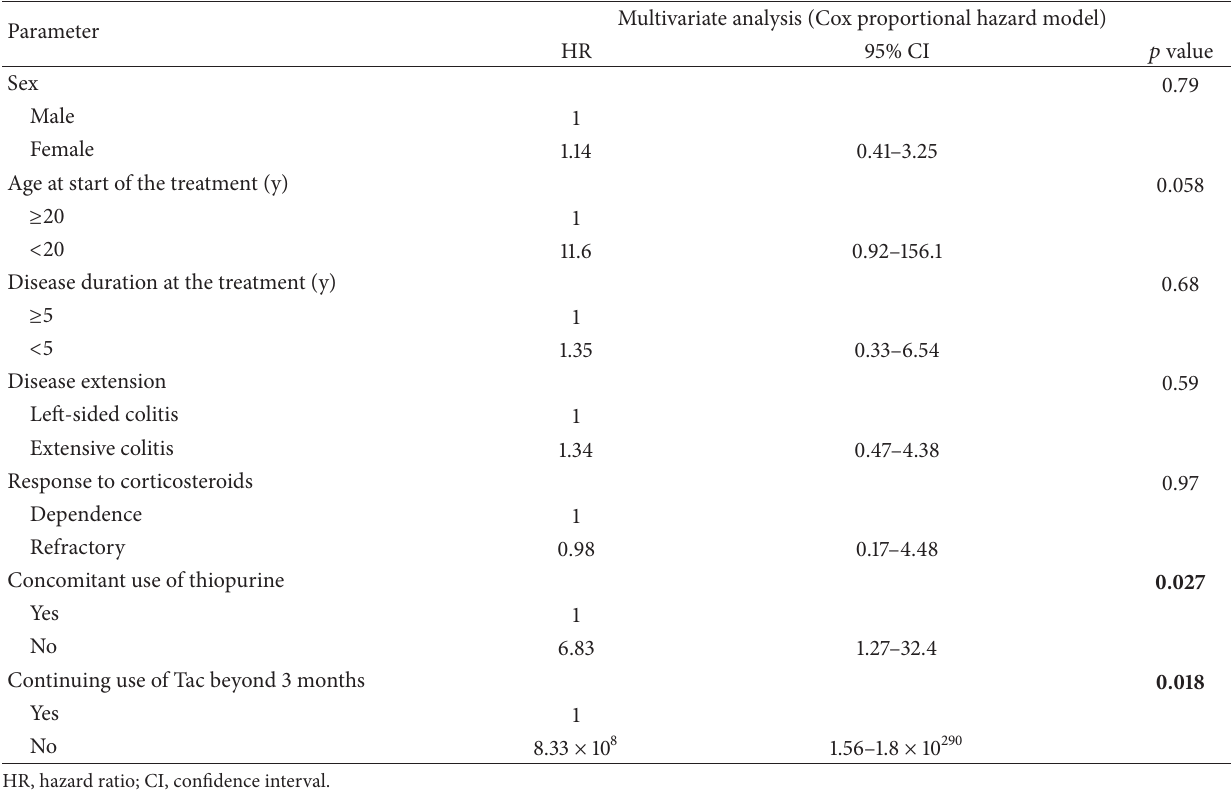
Table 3: Cox proportional hazard model for relapse in Tac group.